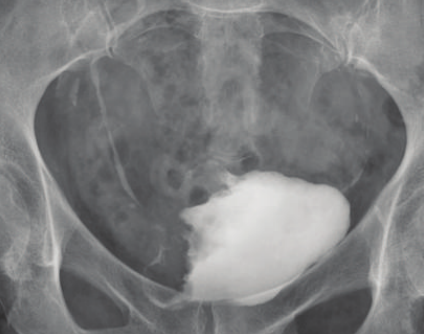
Figure 1: Intravenous urogram (bladder image obtained 15 minutes following contrast administration). There is an infiltrative mass lesion involving the bladder wall on the right. This was confirmed to be a urothelial cell carcinoma following biopsy at cystoscopy.